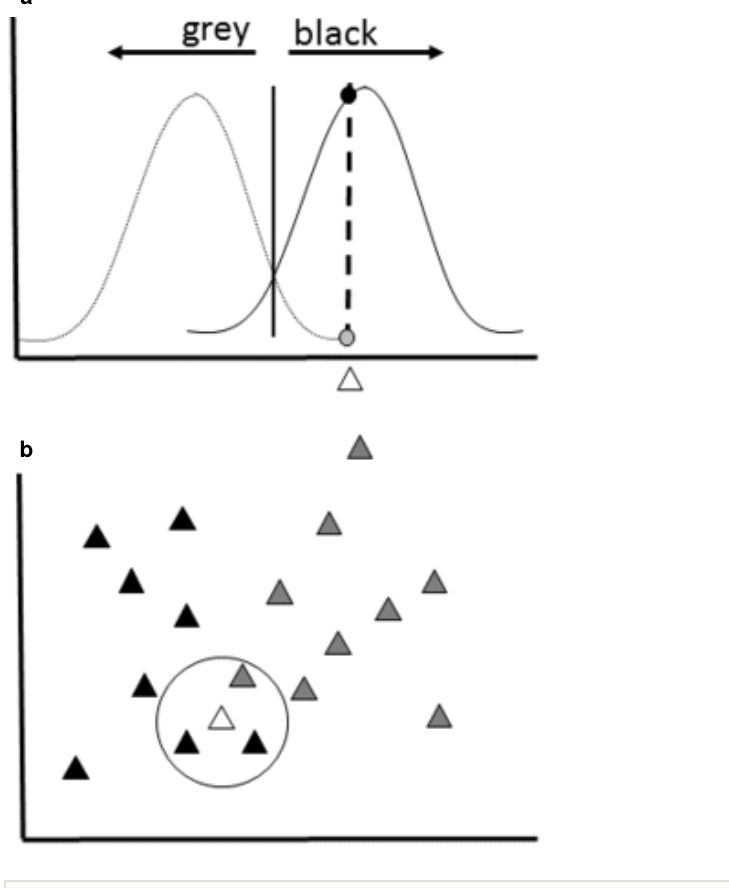
For a more detailed discussion of Bayesian Classi fi ers and Bayesian Networks see section 5.1 in Kotsiantis et al. 2006.